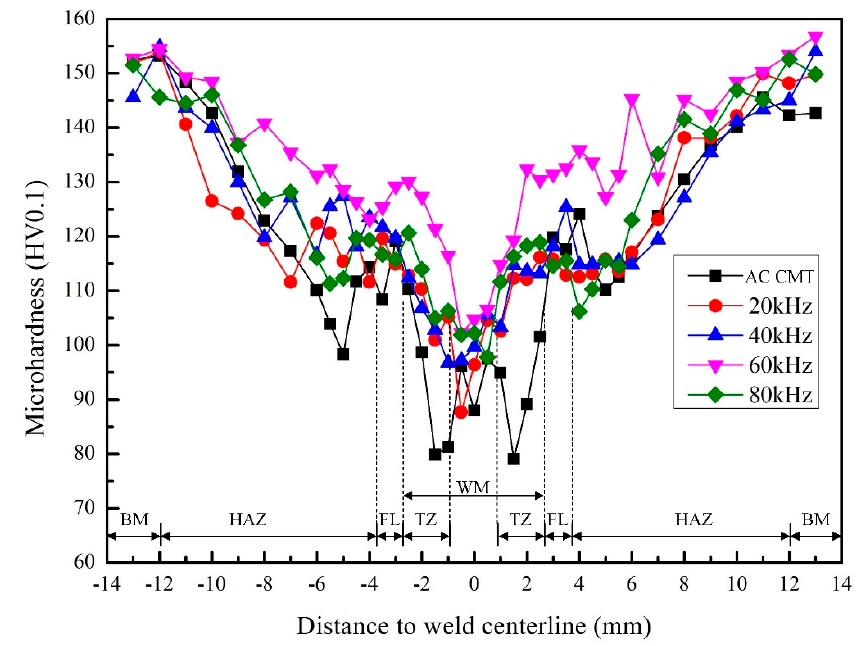
Figure 9. Microhardness distribution of the welded joints welded by AC CMT and AC CMT coupled current at frequency of 20 kHz, 40 kHz, 60 kHz, and 80 kHz, respectively.